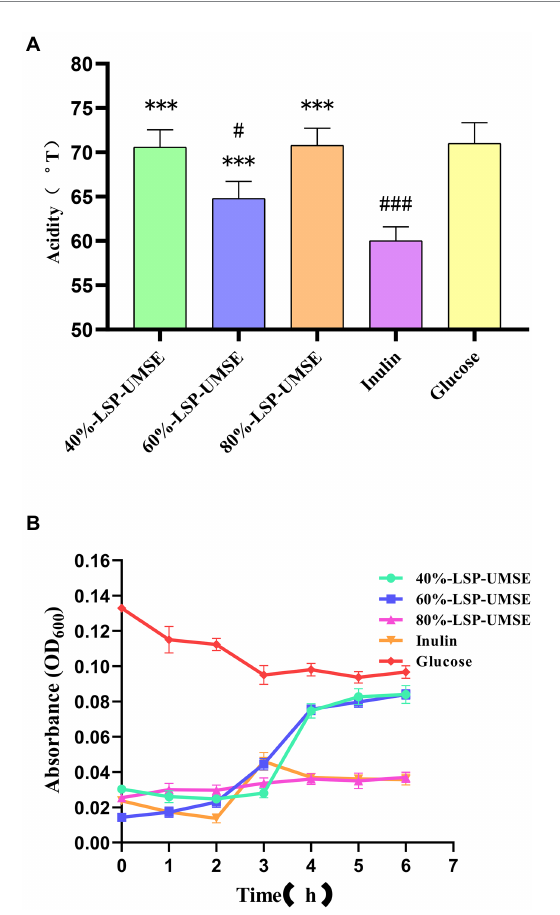
FIGURE 11 (A) Comparison of acidity of 0.5% polysaccharides (glucose: polysaccharide =9:1) MRS medium at 24 h. (B) Bile salt tolerance of L. casei cultured with different carbon sources. (Note: inulin was used as control, *** was extremely significantly p < 0.005; when glucose was used as control, # was significantly p < 0.05; ### is extremely significant, p <